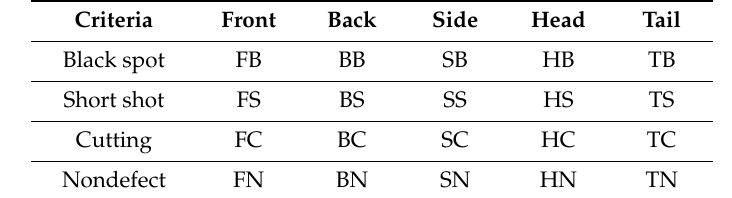
Table 6. Output classes of PE-ResNeXt.